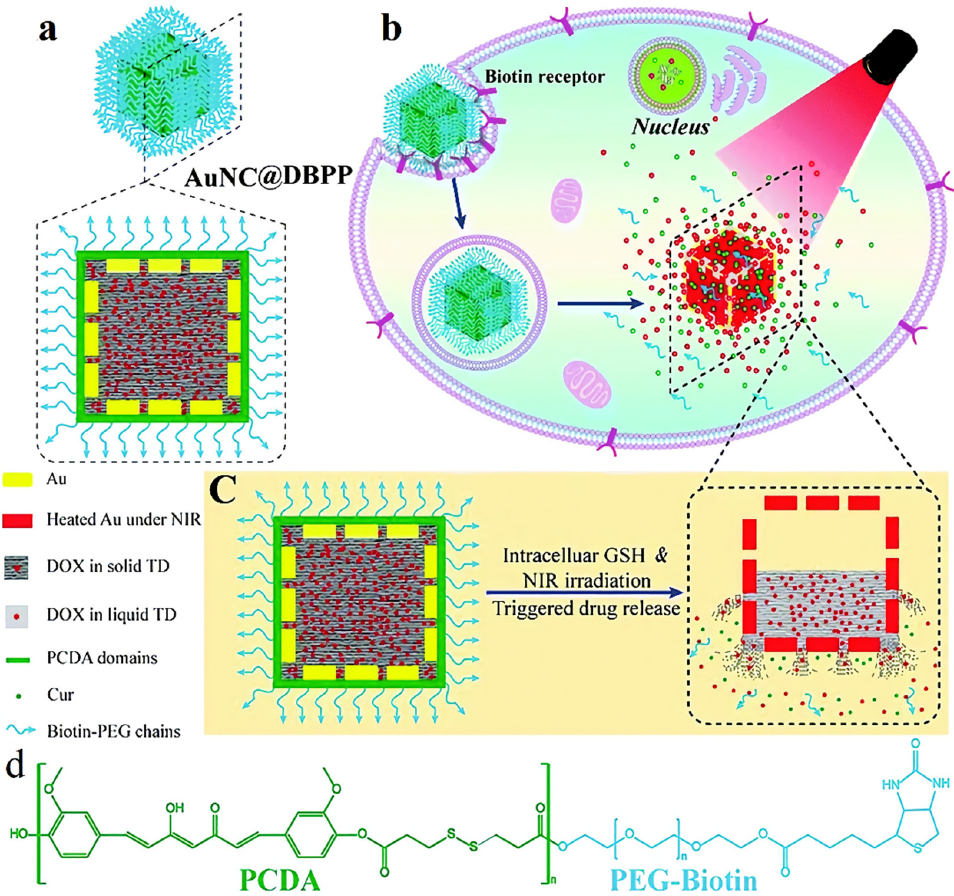
Figure 11. ( a ) Schematic diagram of AuNC@DBPP. ( b , c ) Light- and glutathione-responsive endocellular drug release, and ( d ) molecular structure of BPP. Reprinted/adapted with permission from Ref. [94]. Copyright 2017, The Royal Society of Chemistry.